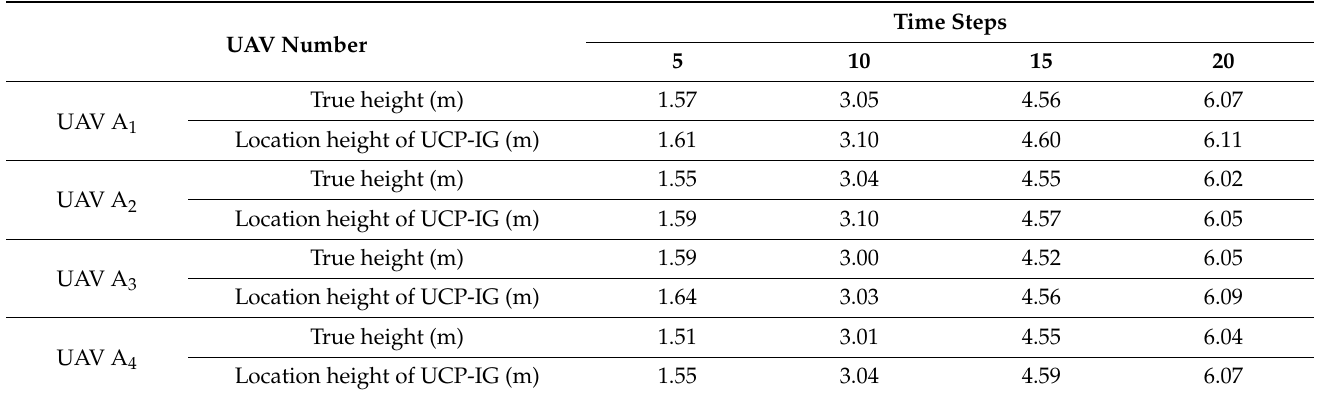
Table 4. Part of the experimental data (experimental random scenario).